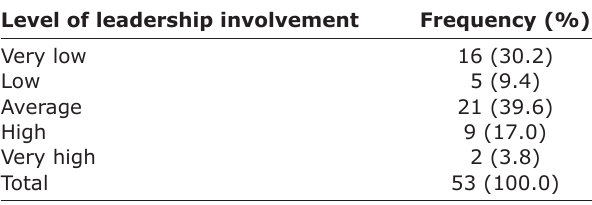
Table-4: Respondents’ levels of leadership in implementation of OH